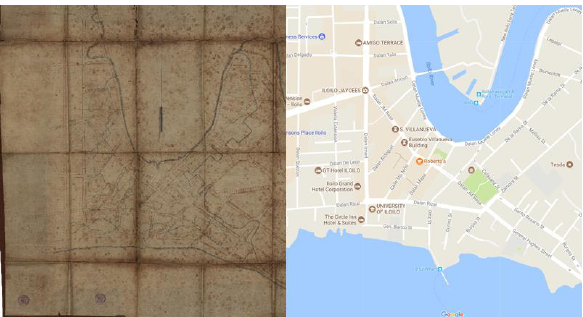
Figure 5. Left - Portion of 1833 Iloilo City map courtesy of the National Archives of the Philippines. Right - corresponding